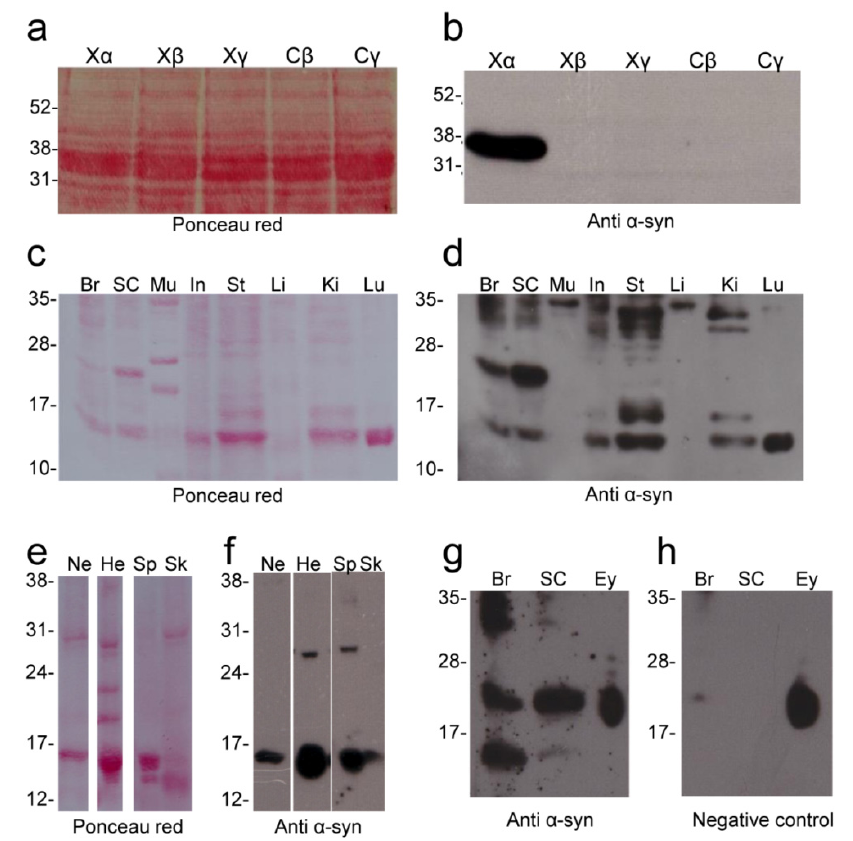
Figure 4. Western blot analysis of α -syn expression by ab27766 antibody. Validation of the antibody on Xenopus (X α , X β , X γ ) and Cyprinus carpio (C β and C γ ) recombinant syns ( a , b ). α -syn expression in the main Xenopus organs ( c , h ). Red ponceau staining is shown in ( a , c , e ). α -syn immunolabelling in ( b , d , f , g ). Negative control (primary antibody omitted) in ( h ). Br: brain; Ey: eye; He: heart; In: intestine; Ki: kidney; Li: liver; Lu: lung; Mu: skeletal muscle; Ne: nerve; SC: spinal cord; Sk: skin; Sp: spleen; St: stomach; X α , X β and X γ : Xenopus recombinant α -, β - and γ -syn, respectively; C β and C γ